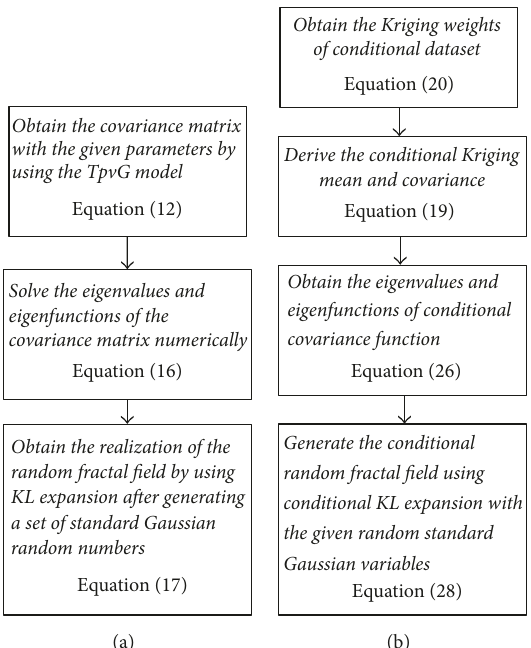
Figure 2: Flowchart to generate the random fractal fields: (a) unconditional; (b) conditional.